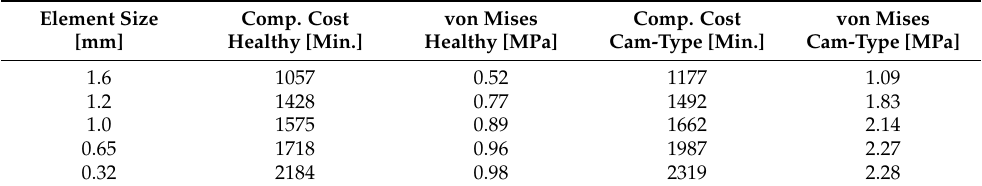
Table 1. Computational cost and maximum von Mises Stress for the element sizes of healthy and Cam-type hip joint FE models.